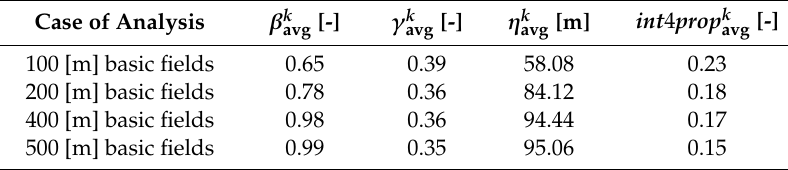
Figure 9. Level of connectivity for each basic field for k = 4 (500 m basic fields): ( a ) beta measure; ( b ) gamma measure; ( c ) eta measure; ( d ) four-way intersection proportion. Table 4. Mean values for each measure of the connectivity of the road and street network- FC